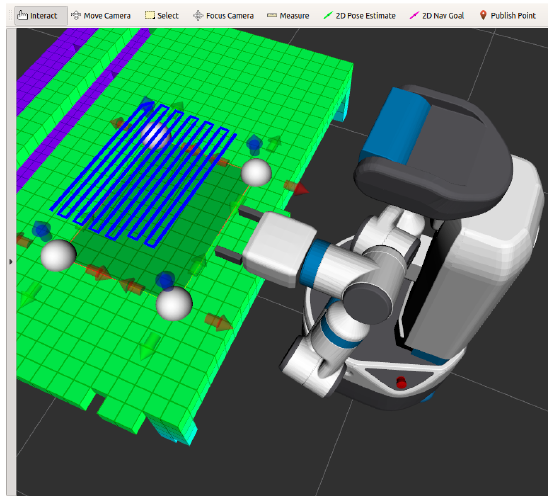
Figure 6. The 3D display interface. This is used to display the model of the environment, and to allow the human supervisor to select points that define the plane to be